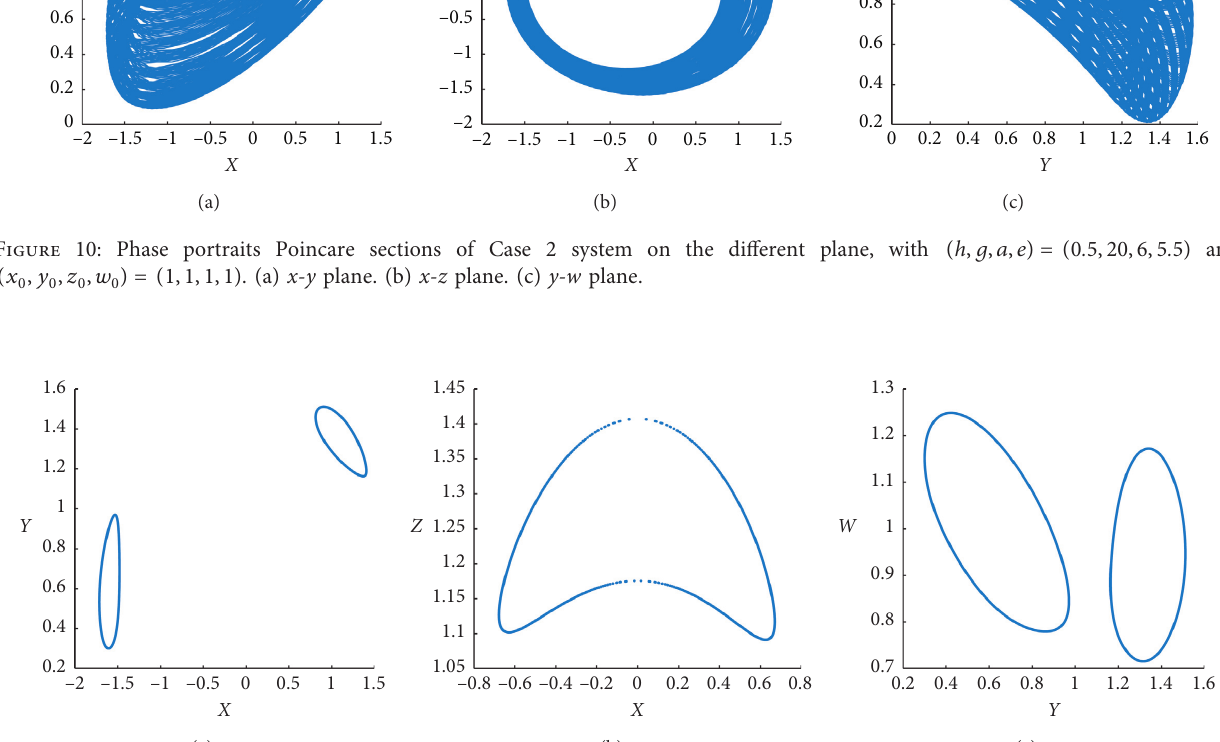
w ) � (1, 1, 1, 1). (a) x-y 0 , y 0 , z 0 , 0